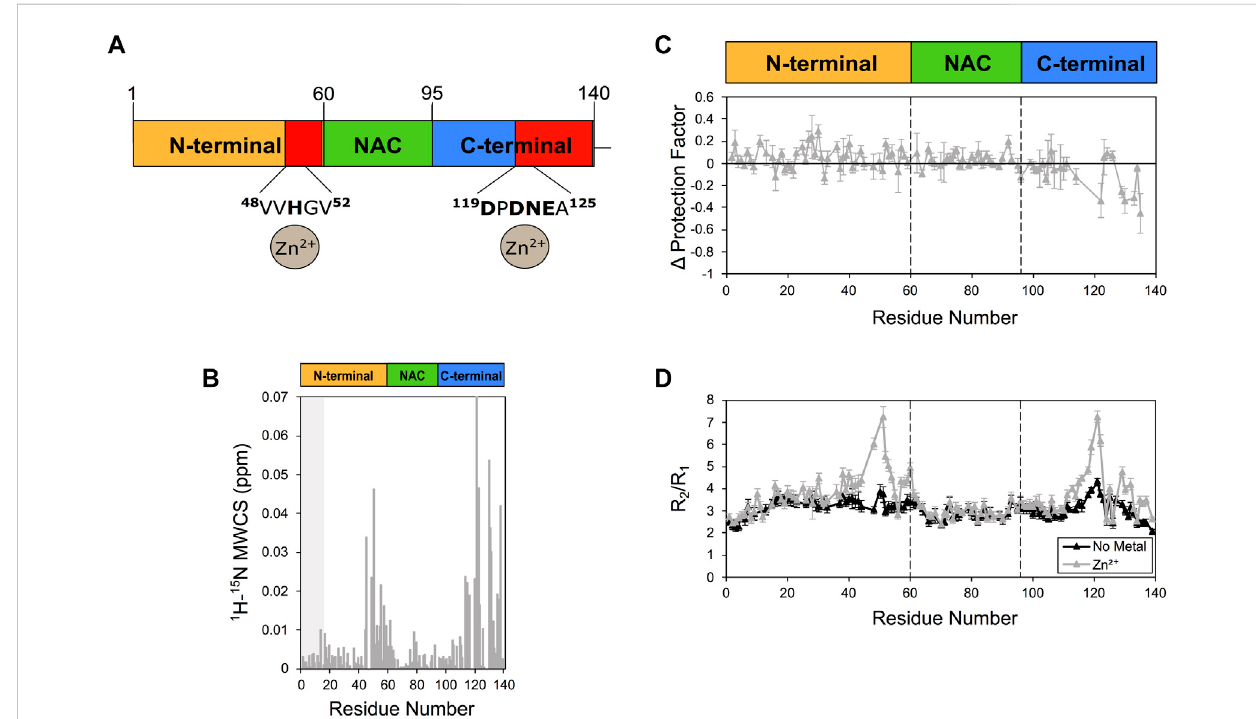
FIGURE 3 NMRanalysisofZn 2+ bindingto α S. (A) SchematicdepictingZn 2+ bindingby α S.RedregionsintheschemeindicatemajorCSPalongthe α Ssequence upon metal binding. (B) Mean weighted CSP ( 1 H- 15 N MWCS) of α S as a result of the zinc binding. The grey box denotes the fi rst 15 residues of the protein. (C) Alteration in the LogP values of α S as a result of Zn 2+ binding. These values are calculated for each α S residue as the logP of the metal bound state minusthelogPoftheisolatedproteinstate. (D) R 2 /R1valuesfrom 15 Nrelaxationdataof α Sinthepresence(gray)andabsence(black)ofzinc(rawdata in Supplementary Figure S8). Error bars are calculated from the fi tting errors in R 1 and R 2 measurements. Dotted lines delineate the different regions (N-terminal, NAC, and C-terminal) along the sequence of α S. Experiments were performed at 10 ° C in 25 mM Tris buffer and a pH of 7.0, and using concentrations of α S and Zn 2+ of 415 μ M and 2.1 mM,